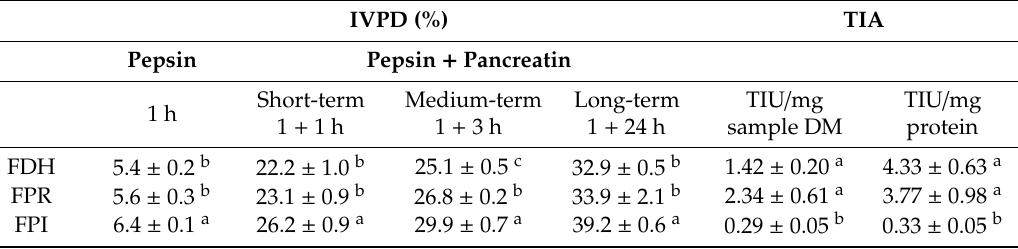
Table 5. In vitro protein digestibility (IVPD) 1 and trypsin inhibitor activity (TIA) 2 of faba bean ingredients. IVPD (%) TIA Pepsin Pepsin +